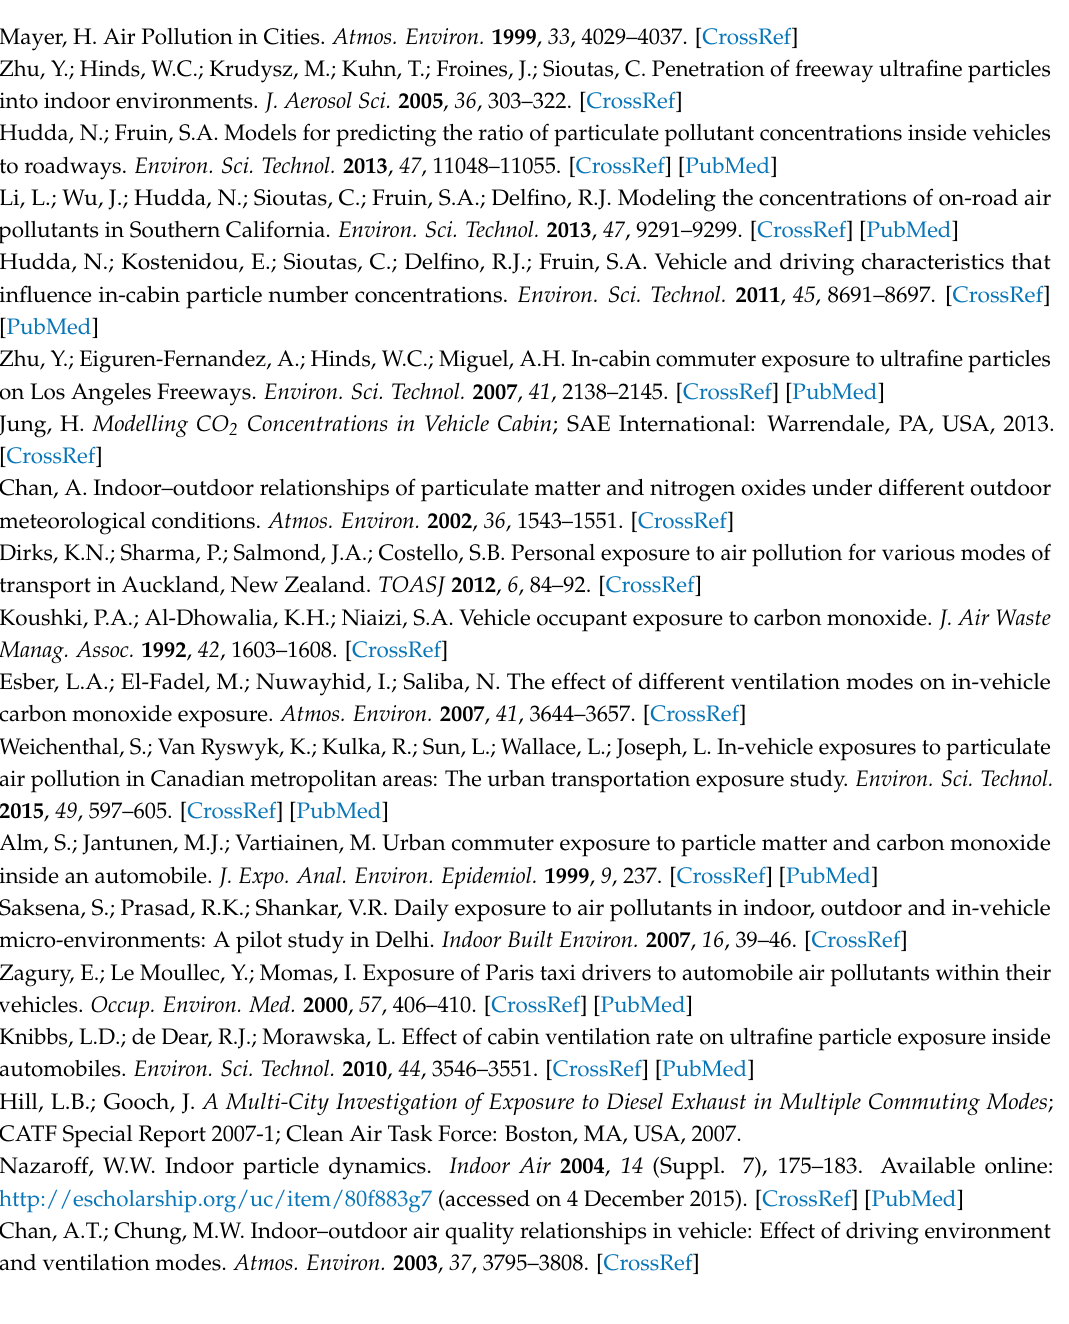
Figure S1 Time series data from an on-road spike to estimate the vehicle ventilation rate during new air ventilation setting during morning commute, Figure S2: Annual averaged 24-h CO data collected from Penrose air quality monitoring